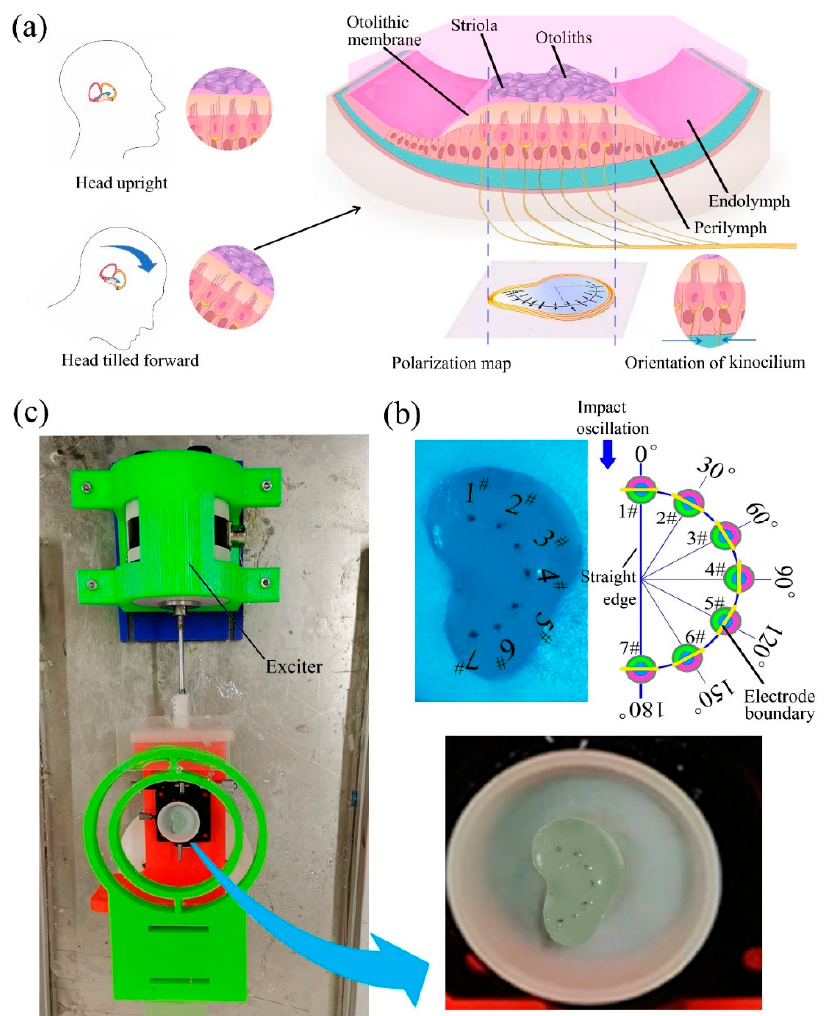
Figure 3. ( a ) A diagram of the human macula. The polarity of sensory cells on one side of the striola is opposite to that on the other side. ( b ) A photograph of the BM. ( c ) A photograph of the experimental system.